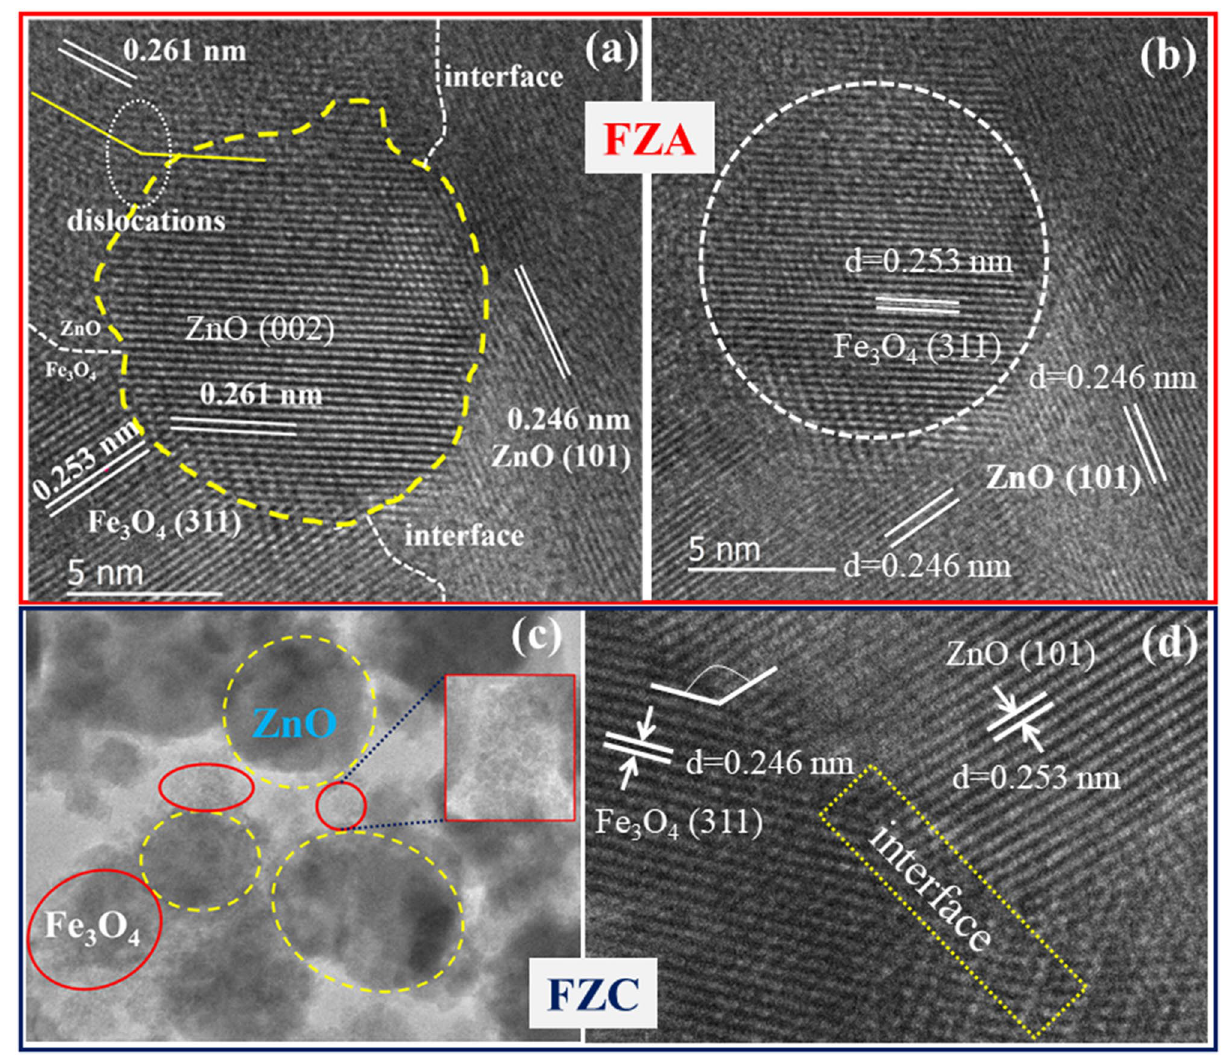
Figure 5. ( a – b ) HRTEM images of the sample FZA showing interfering grain boundaries of the ZnO and Fe 3 O 4 nanoparticles. ( c – d ) HRTEM images of the sample FZC with overlapping grain